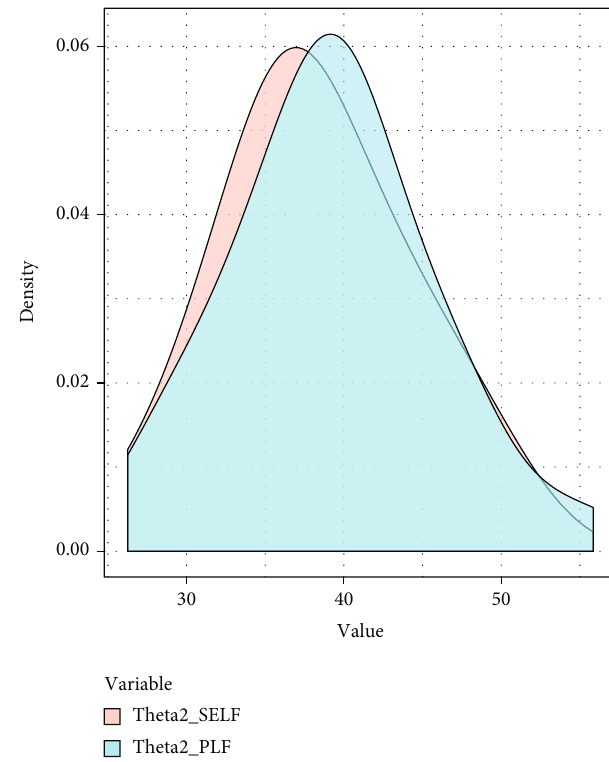
Figure 4: The marginal density for θ